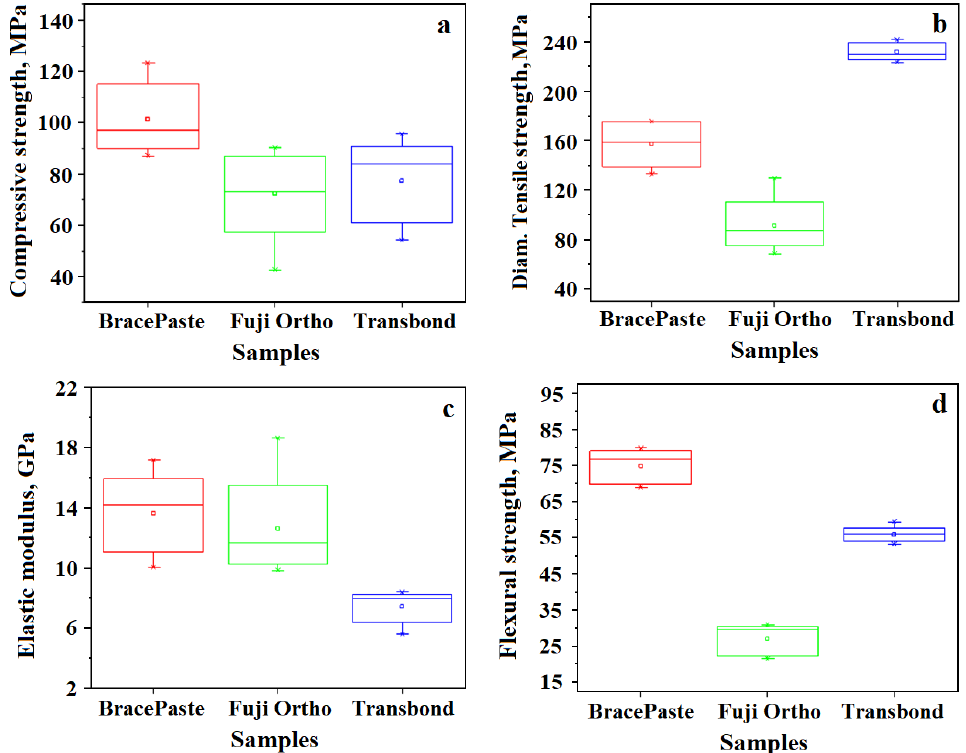
Figure 1. Mechanical properties variation for the initial cement samples with statistical analysis: ( a ) compressive strength, ( b ) diametraltensile strength, ( c ) elastic modulus and ( d ) flexural strength.